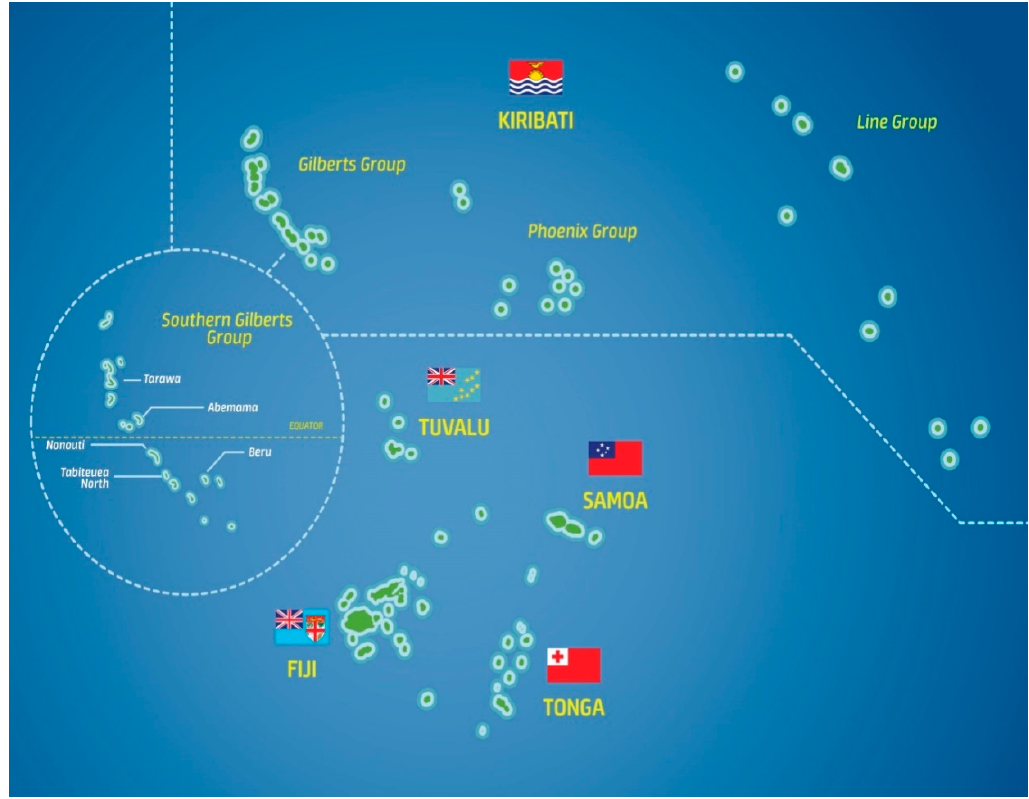
Figure 1. Map of part of the south-western Pacific Ocean, featuring Kiribati, Tuvalu, and Fiji, and (inset) the Southern Gilbert Islands. This project focused on Abemama, Tabiteuea North, Nonouti, and Beru, and (for value-chain activity) Abaiang, just north of Tarawa.